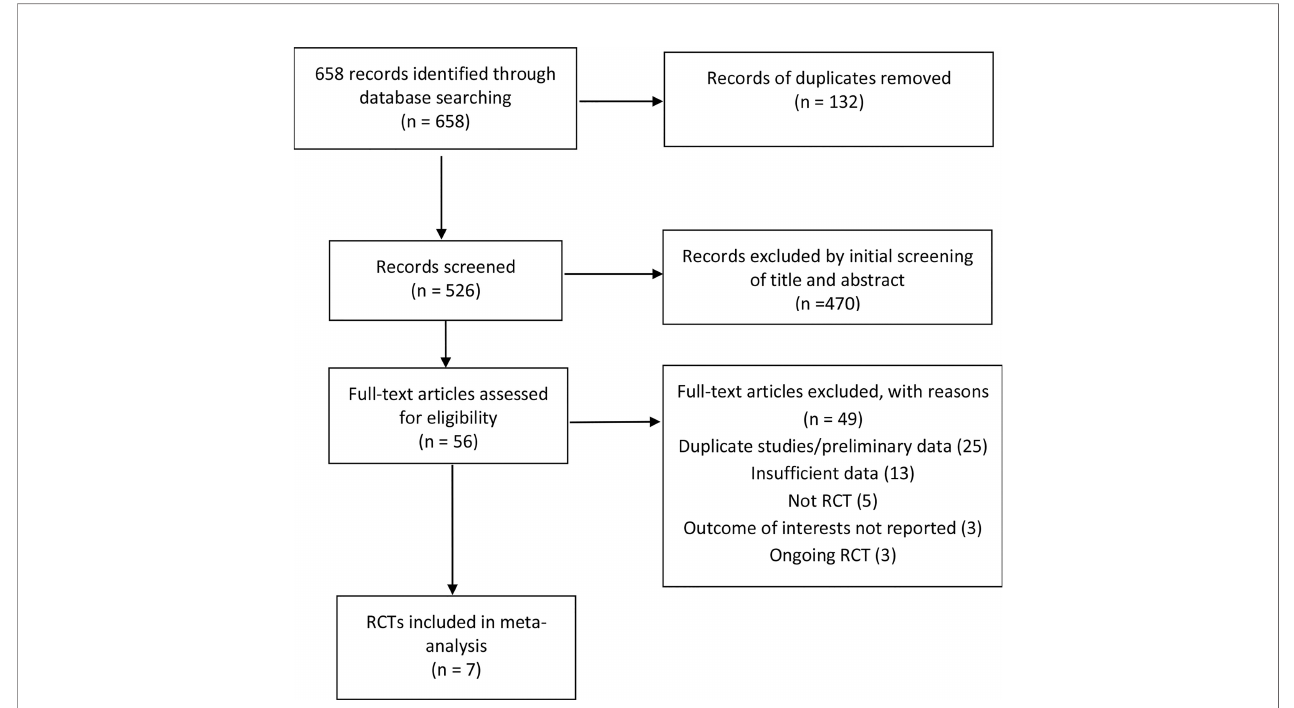
FIGURE 1 | Flow diagram of included RCTs identi fi ed for